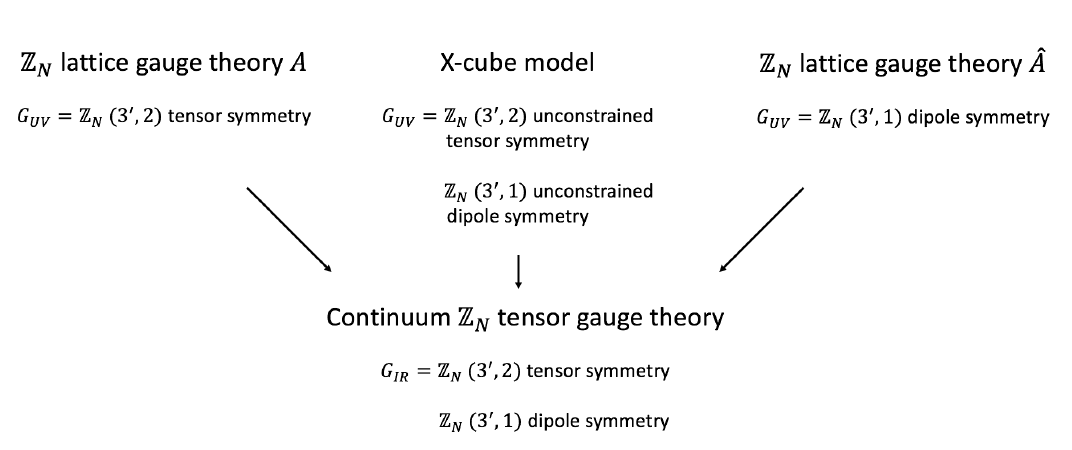
ˆ A -theory, and the X-cube A -theory, the (cid:90) N N at long IR